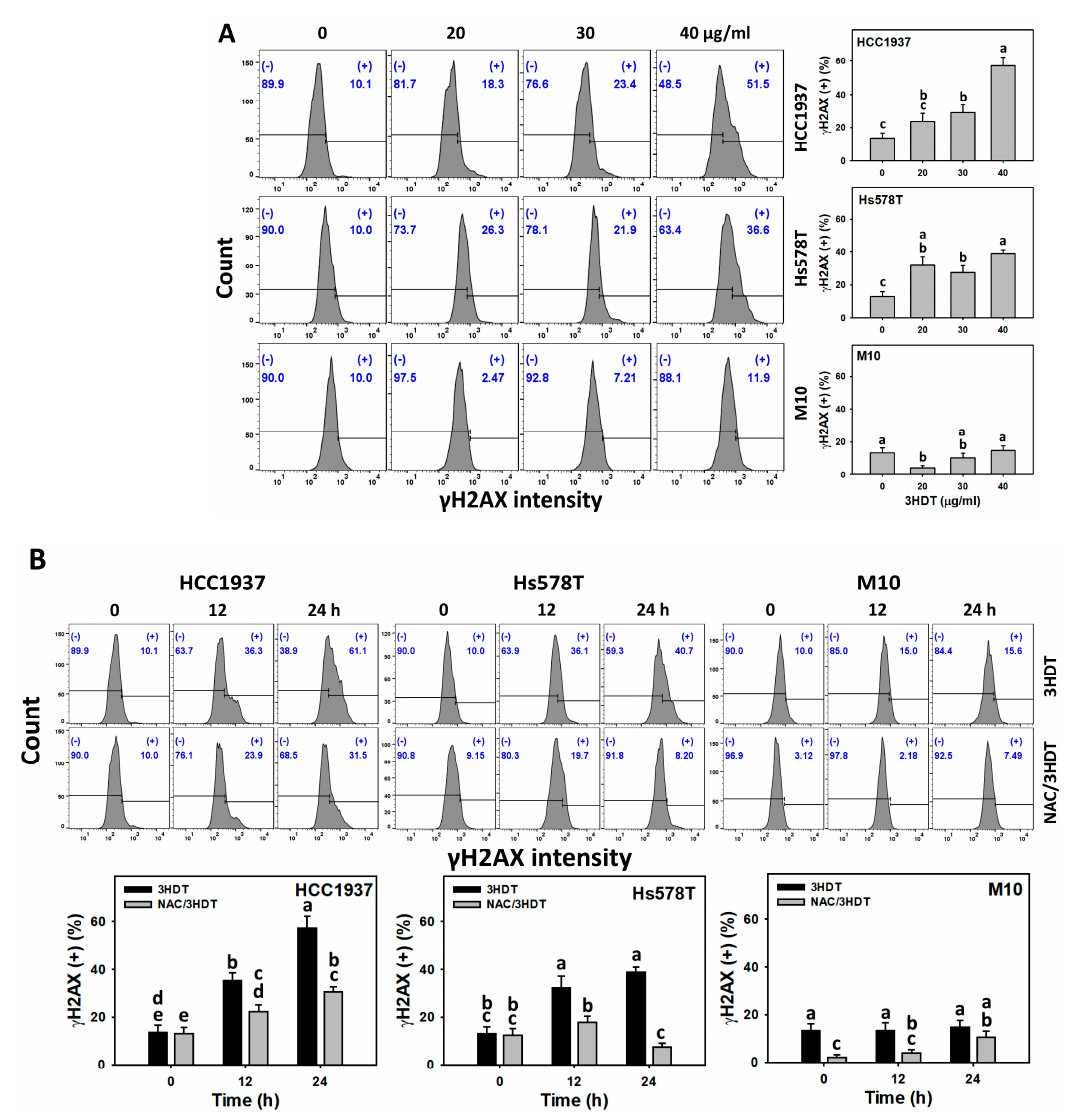
Figure 8. γ H2AX status of 3HDT treatment. ( A ) γ H2AX flow cytometry assay of 3HDT for 24 h. ( B ) γ H2AX flow cytometry assay of NAC/3HDT. 3HDT and NAC/3HDT indicate 12 or 24 h 3HDT treatment (40 µ g/mL) without and with NAC pretreatment, respectively. (+) is marked as γ H2AX (+), which indicates the proportion with high γ H2AX level, while ( − ) indicates the proportion with low γ H2AX level. Data: mean ± SD ( n = 3). Treatments differ significantly for multiple comparisons when the letters are not overlapping ( p < 0.05).